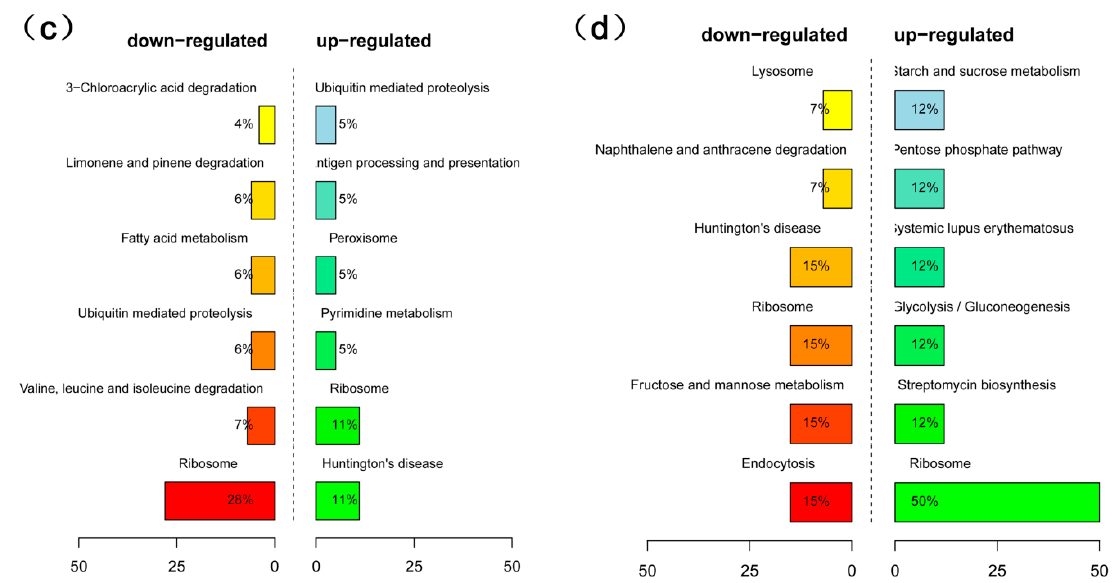
Figure 3. KEGG pathway enrichment analysis based on identified DEGs. KEGG pathway enrichment analysis based on associated DEGs between ( a ) HO40 and LO40, ( b ) HO54 and LO54, ( c ) HO68 and LO68, and ( d ) HO81 and LO81.